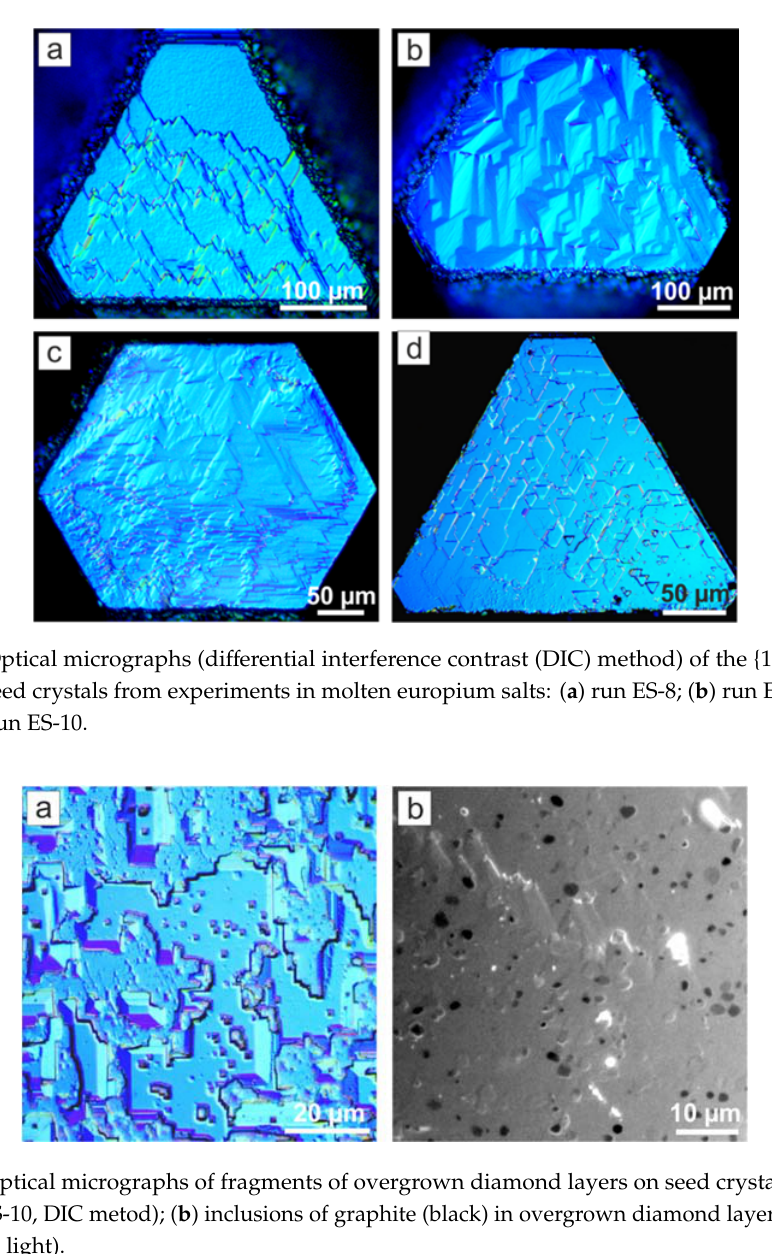
Figure 3. Optical micrographs (differential interference contrast (DIC) method) of the {111} faces of diamond seed crystals from experiments in molten europium salts: ( a ) run ES ‐ 8; ( b ) run ES ‐ 6; ( c ) run ES ‐ 12; ( d ) run ES ‐ 10.